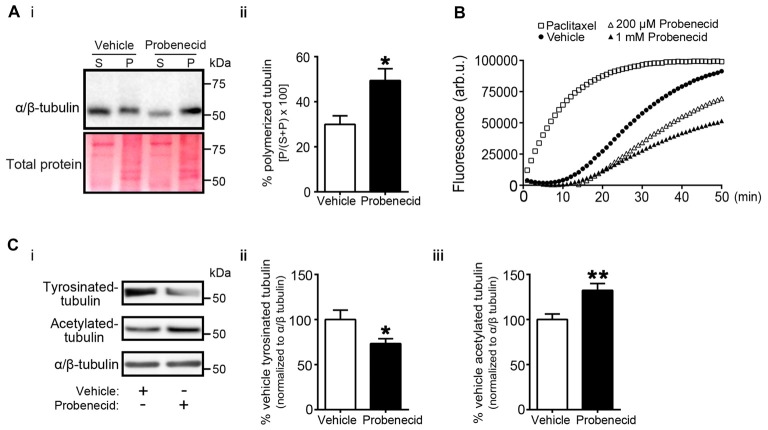
Probenecid treatment increases microtubule stability in cells. (Ai) N2a cells were treated with vehicle control or probenecid and then fractionated to obtain polymerized and soluble microtubule fractions. P (pellet) contains the polymerized microtubule fraction and S (supernatant) contains the soluble tubulin fraction. Ponceau S staining was employed as a loading control. (ii) Probenecid enhanced the percentage of polymerized microtubules to soluble tubulin (vehicle: 29.9 ± 3.8% vs. probenecid: 49.4 ± 5.2%, p = 0.0107 by unpaired t-test; n = 7). (B) Tubulin polymerization assays in vitro. Paclitaxel (3 μM) and vehicle were employed as positive and negative controls, respectively. The experiment was performed three times, with the replicates as follows: paclitaxel n = 5; Vehicle n = 5; 200 μM Probenecid n = 5; 1 mM Probenecid n = 7. (Ci) Western blot of post-translationally modified tubulin species from N2a cells treated with probenecid or vehicle control. Tyrosinated-tubulin represents the dynamic population, and acetylated-tubulin represents the stable population. Total α/β-tubulin was used for normalization. Probenecid treatment (ii) decreased tyrosinated-tubulin (100.0 ± 10.5% vs. 73.3 ± 5.5%, p = 0.0377 by unpaired t-test; n = 9) and (iii) increased acetylated-tubulin (100.0 ± 6.1% vs. 132.0 ± 7.6%, p = 0.0043 by unpaired t-test; n = 9).